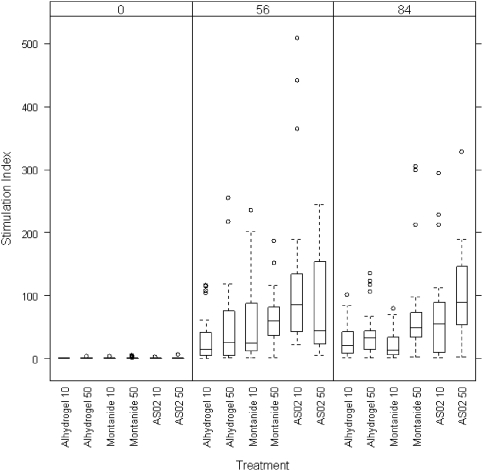
Stimulation indices in response to 6 µg/ml PfAMA1 presented as box plots and whiskers.Peripheral Blood Mononuclear Cells from immunised volunteers 28 days after the second immunisation and 28 days after the third immunisation (Day 56 and 84 respectively) were stimulated with 6 µg of PfAMA1 vaccine. Cell proliferation was measured by adding 3H thymidine and calculated relative to control wells. Box plots and whiskers show the range and the 25th, 50th and 75th percentile. Circles represent outliers. Measurements were performed at baseline, 28 days after the second immunisation and 28 days after the third immunisation (day 56 and 84 respectively).